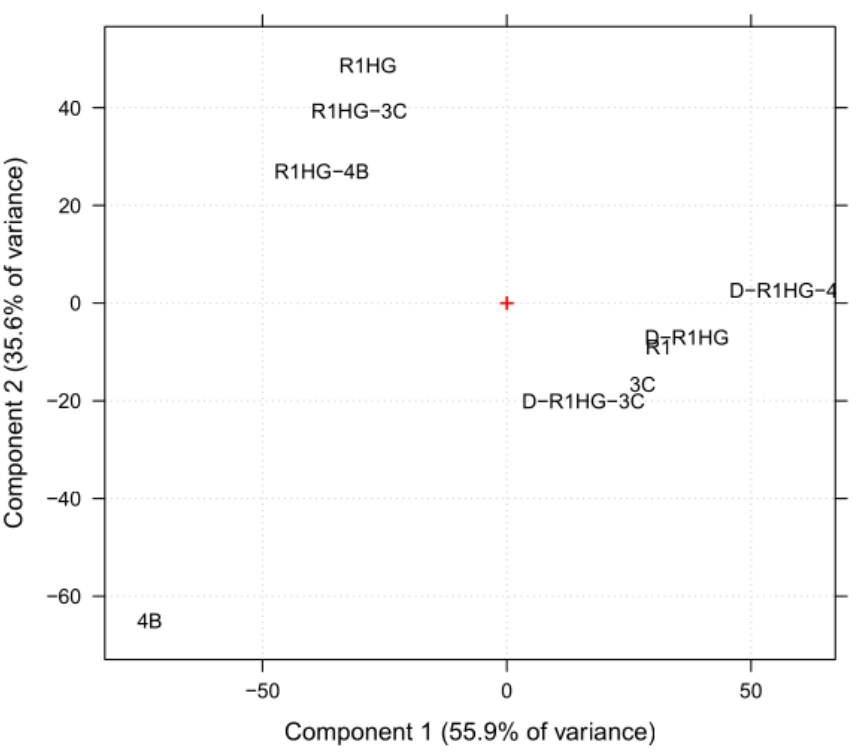
Figure 9. Results by PCA performed on the matrix collecting spectral data of 3c , 4b , R1, R1HG, D-R1HG, R1HG-3c, R1HG-4b, D-R1HG-3c, and D-R1HG-4b represented as a score plot of PC1 vs. PC2.